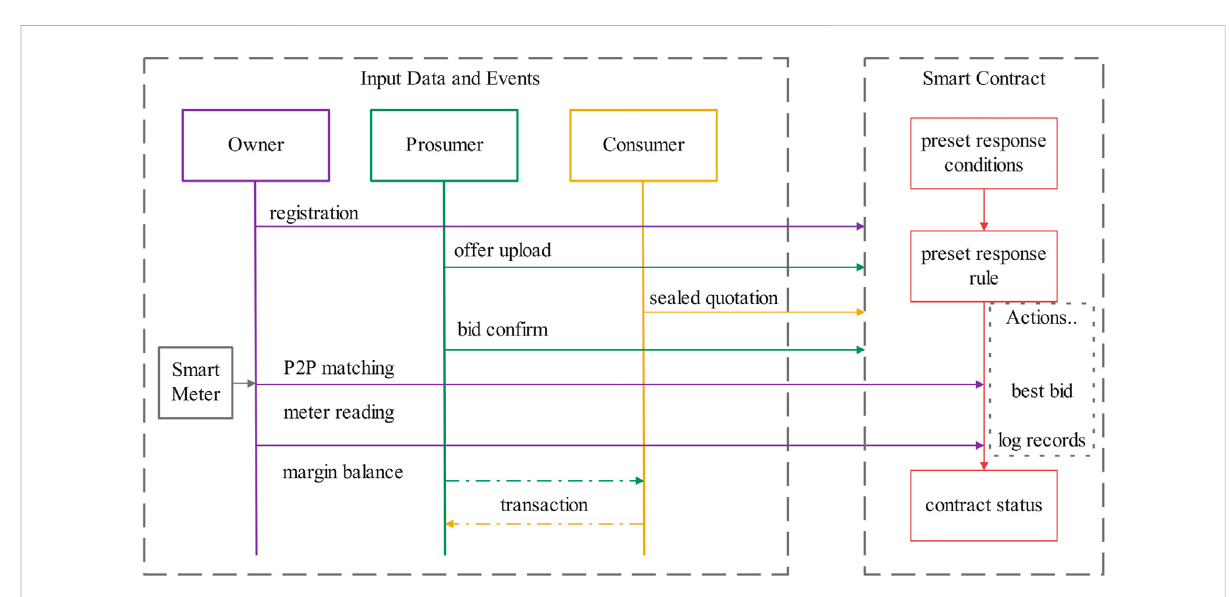
FIGURE 2 Logical relationship of contract